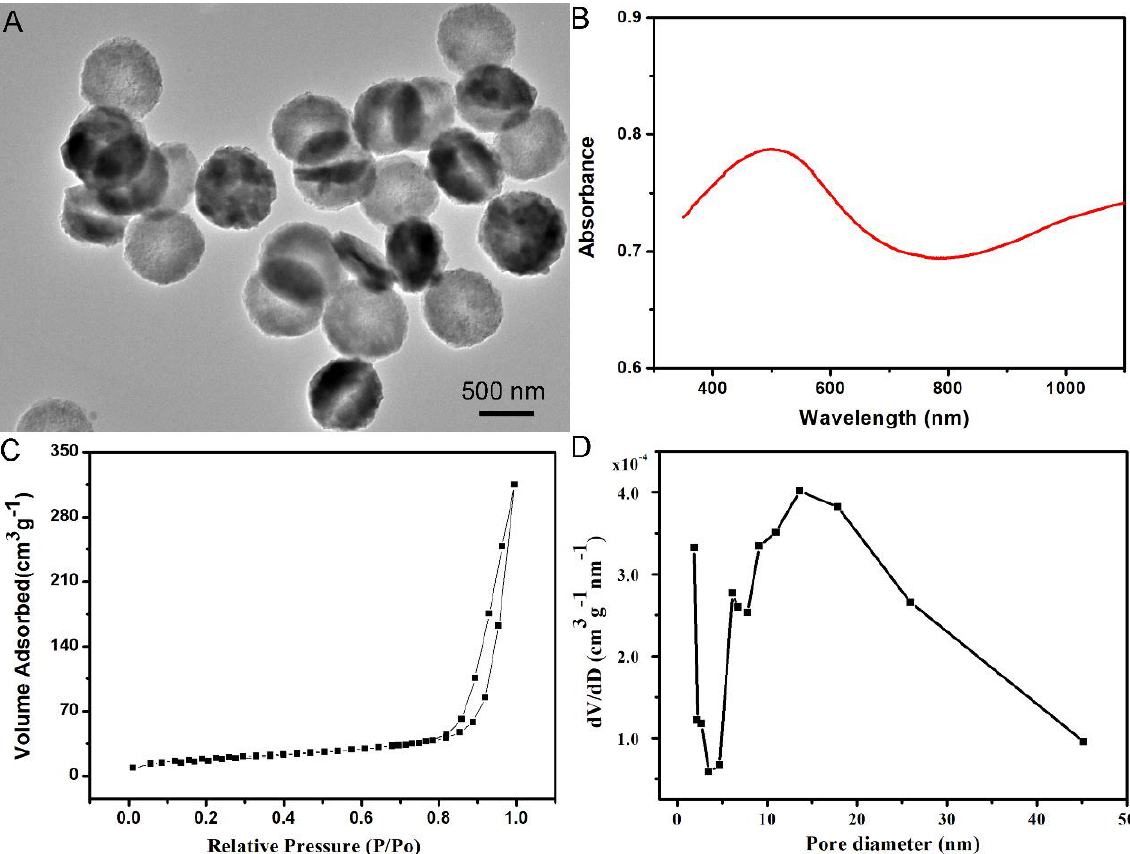
Figure 1. Characterization of self − assembled CuCo 2 S 4 NCs. ( A ) TEM image of the self − assembled CuCo 2 S 4 NCs. Scale bar = 500 nm. ( B ) UV − vis − NIR absorption spectrum of the solution of self-assembled CuCo 2 S 4 NCs at room temperature. ( C ) Surface area of self-assembled CuCo 2 S 4 NCs. ( D ) Pore − size distributions of self-assembled CuCo 2 S 4 NCs.